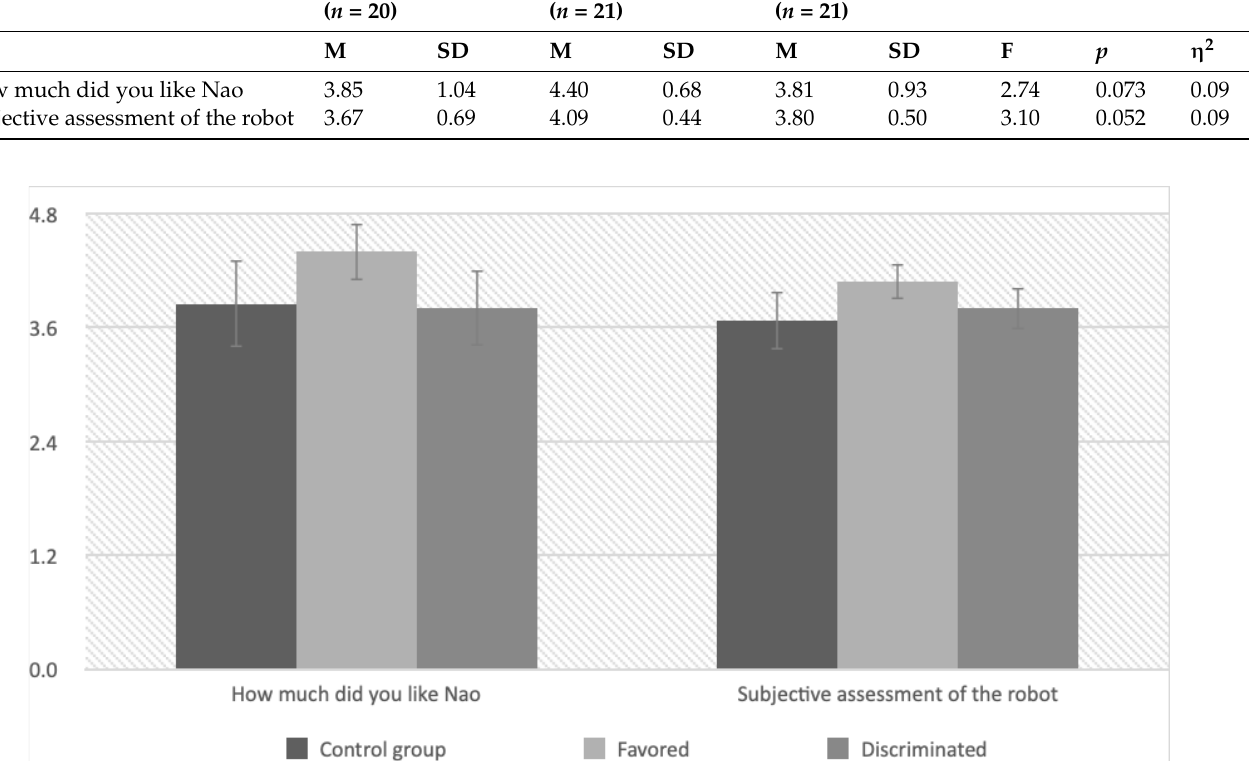
Figure 4. Means with 95% confidence interval for the robot’s likeability variable and indicator of its subjective assessment.